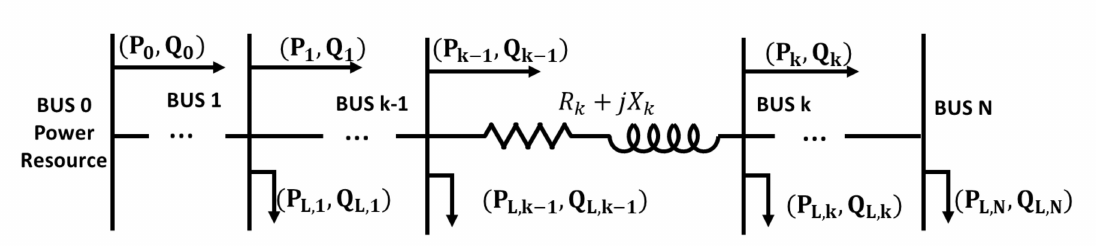
Figure 3. The adjacent buses in a distribution feeder